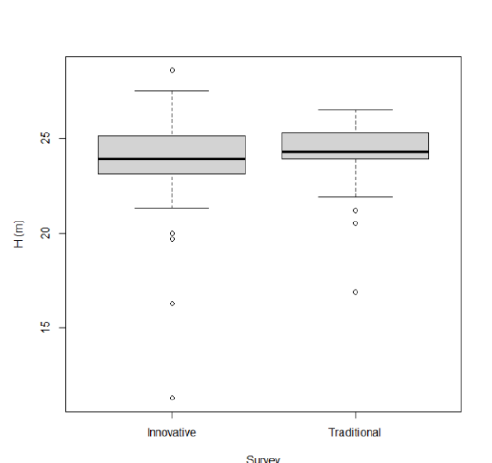
Figure 4.b Boxplots with resulting values for tree height (H) of plot 6-Silver Fir forest.